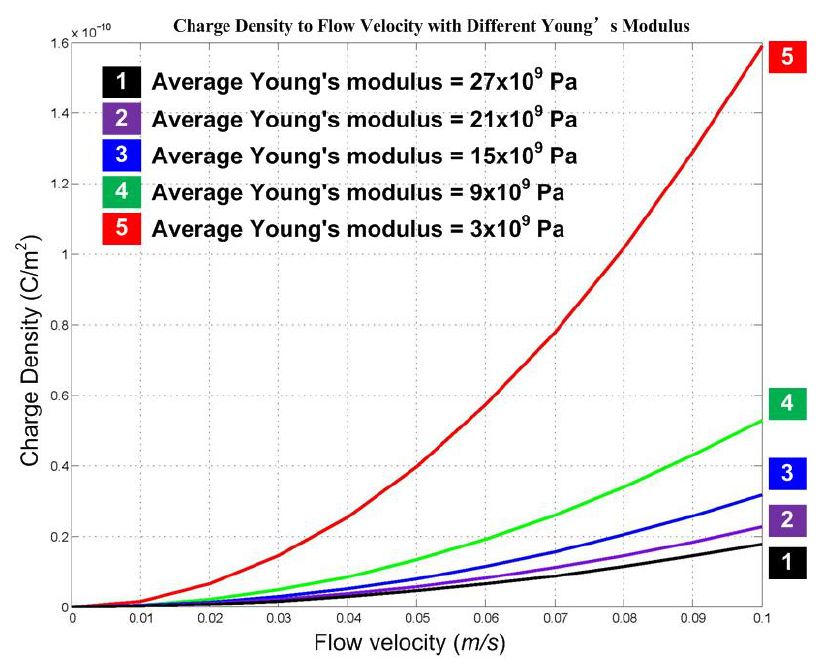
Figure 6. Relationship between charge density and flow velocity with different Young’s